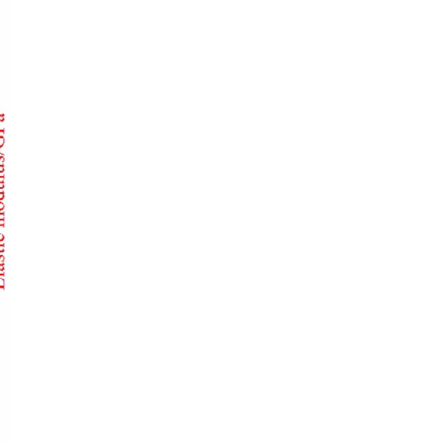
Figure 4. Variation of UCS and elastic modulus of a sample model with different flaw inclination angles.